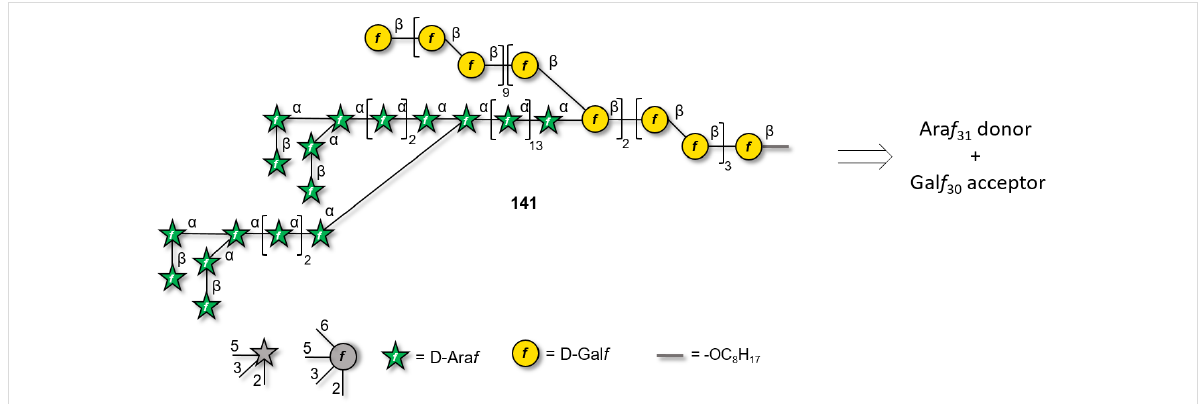
Figure 15: The 92mer arabinogalactan was synthesized using a [31 + 31 + 30] fragment coupling between a 31mer arabinan donor (Ara f 31 ) and a 30mer galactan acceptor (Gal f 30 ).